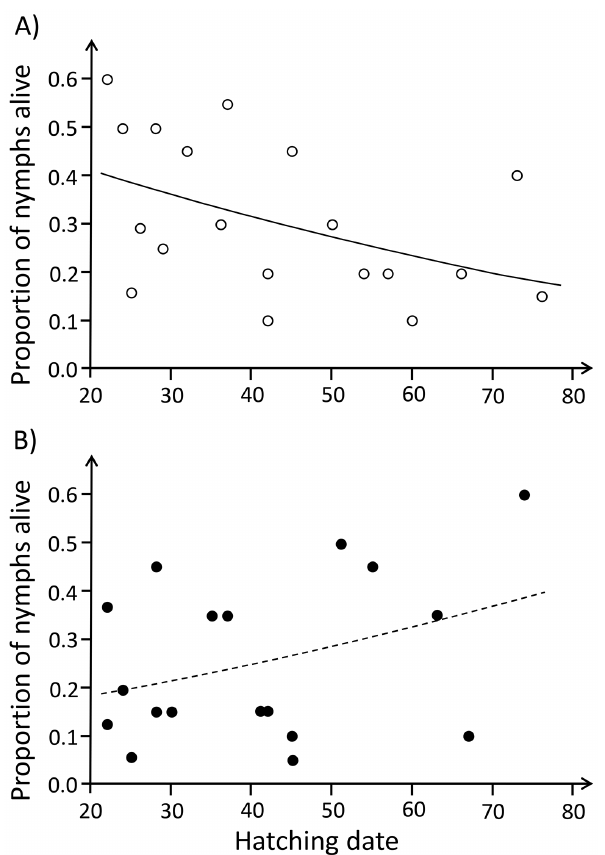
Figure 1. Relationship between the proportion of nymphs alive and brood hatching date for the two female condition treatments. A) low-condition treatment, B) high-condition treatment. Female condition was manipulated by varying experimentally the quantity of food to which the females had access (see Materials and Methods). On the x-axis, a julian date is provided with 6.2.2011 corresponding to day 1. subjects effects: compound 6 treatment interaction). Conversely,